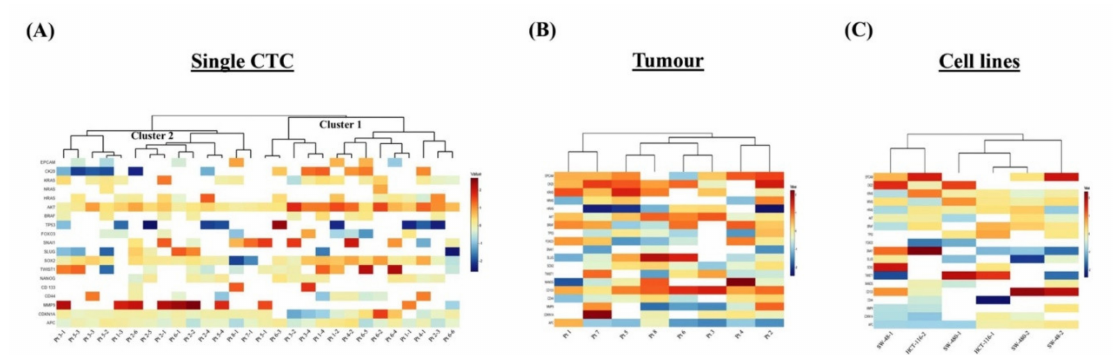
Figure 2. Single-cell genetic analyses of the CTCs, primary carcinomas and colon carcinoma cell lines. Heatmap of the heterogeneous expression of 19 genes from ( A ) single CTCs ( n = 28), ( B ) primary